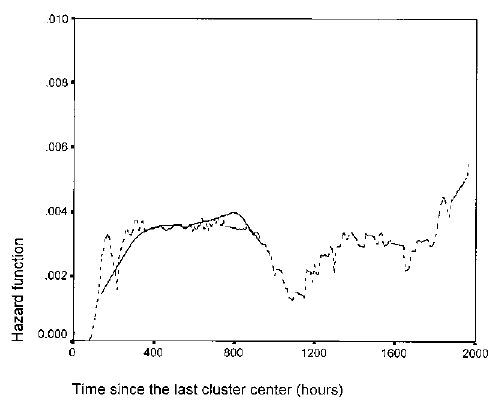
(cid:2)(cid:2) is large compared 132